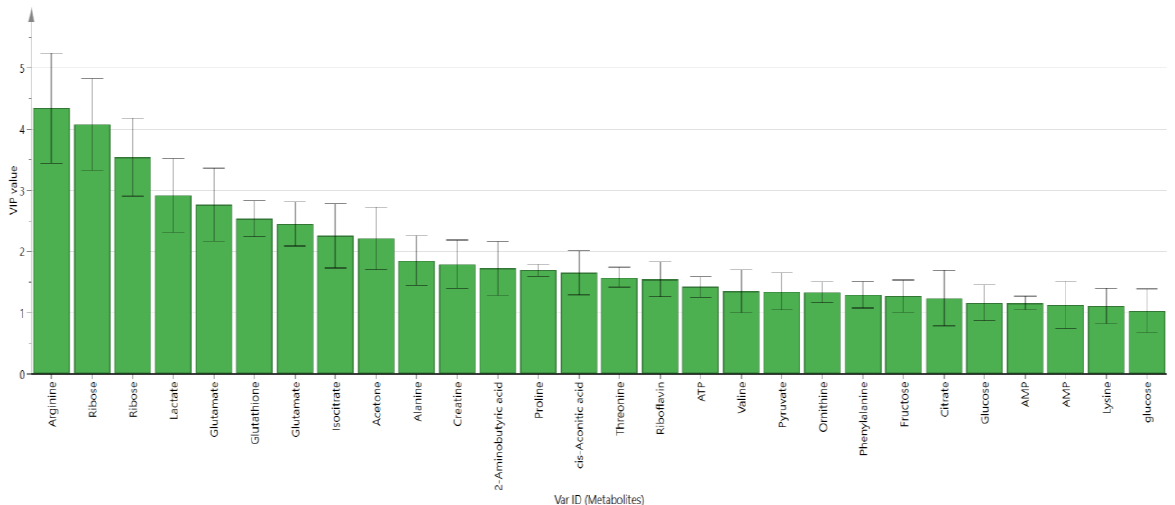
Figure 5. Variable importance of projection (VIP) values of the influential contributing metabolites in the OPLS-DA score plot of uninfected RBCs-control and uRBCs-CQ, error bars represent the standard error of the mean (SEM), uRBCs; uninfected red blood cells, AG; andrographolide.